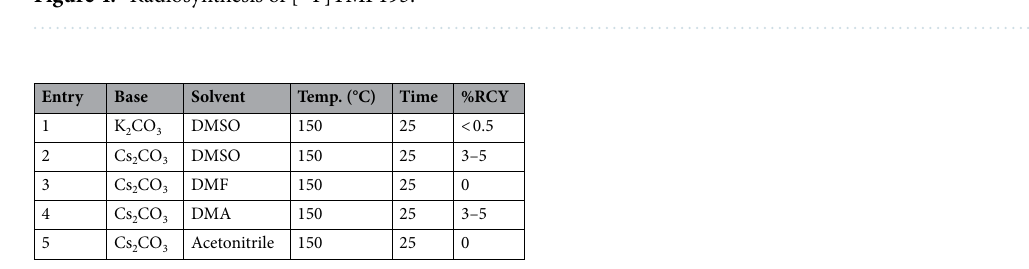
Figure 4. Radiosynthesis of [ 18 F]TMP195.